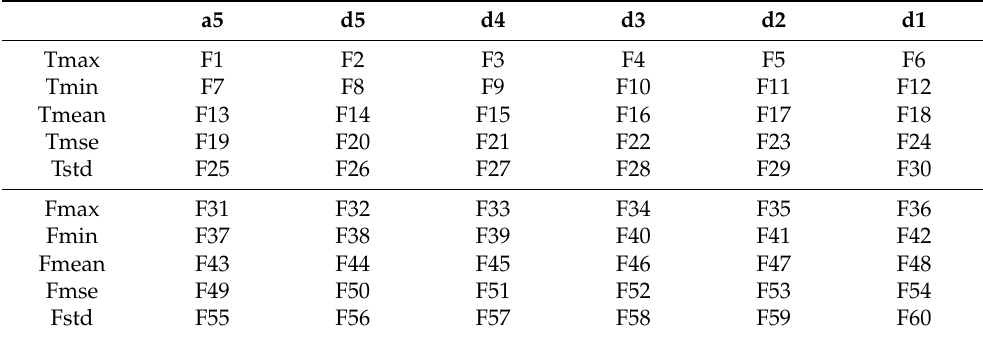
Figure 5. Feature distribution of the MRA. ( a ) Normal motor, ( b ) bearing fault, ( c ) interturn short circuit, ( d ) broken rotor bar. Table 1. Feature extraction of the MRA.